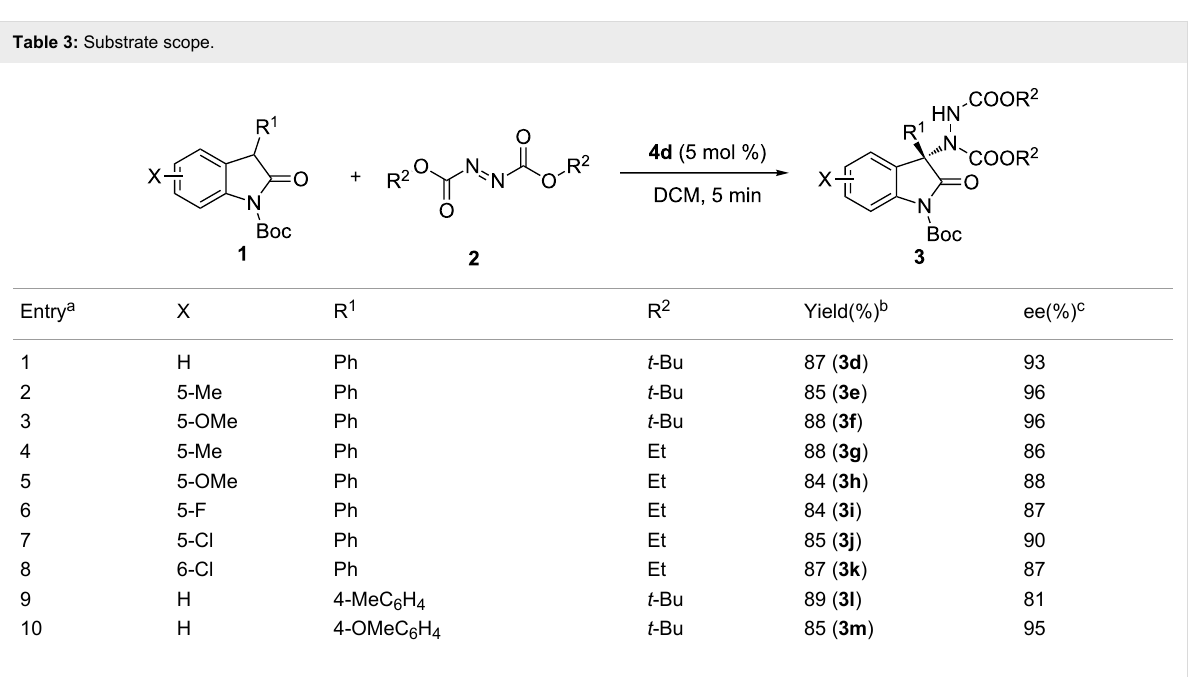
Table 3: Substrate